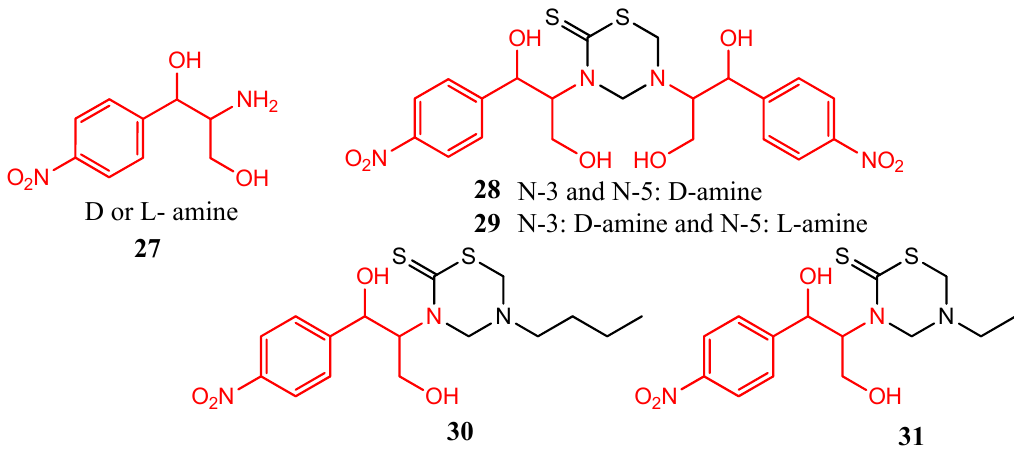
Figure 9. THTT derivatives with antibacterial and antifungal activity.